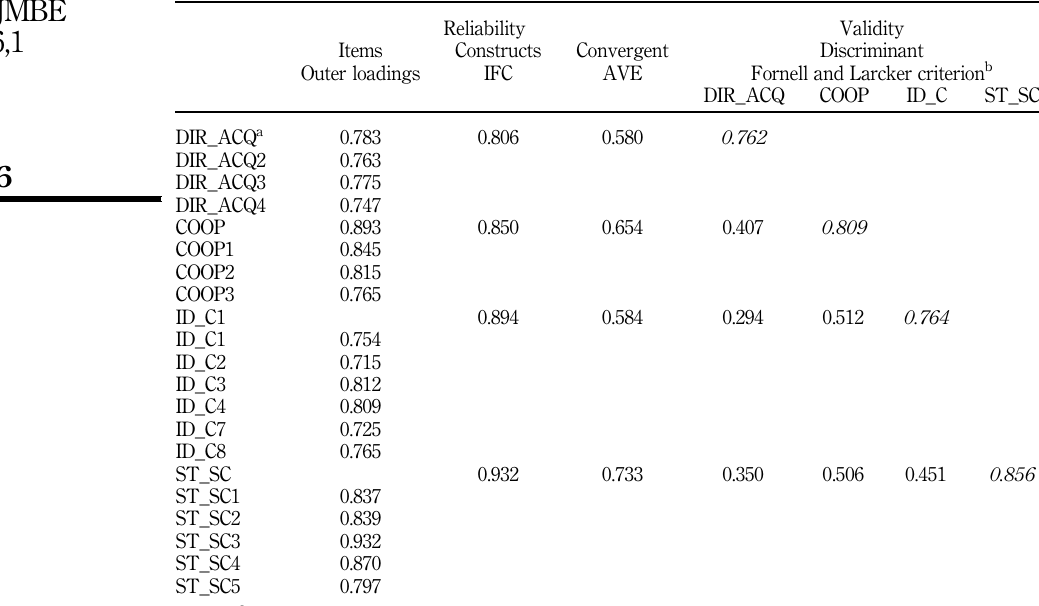
Table III. Measurement first- order